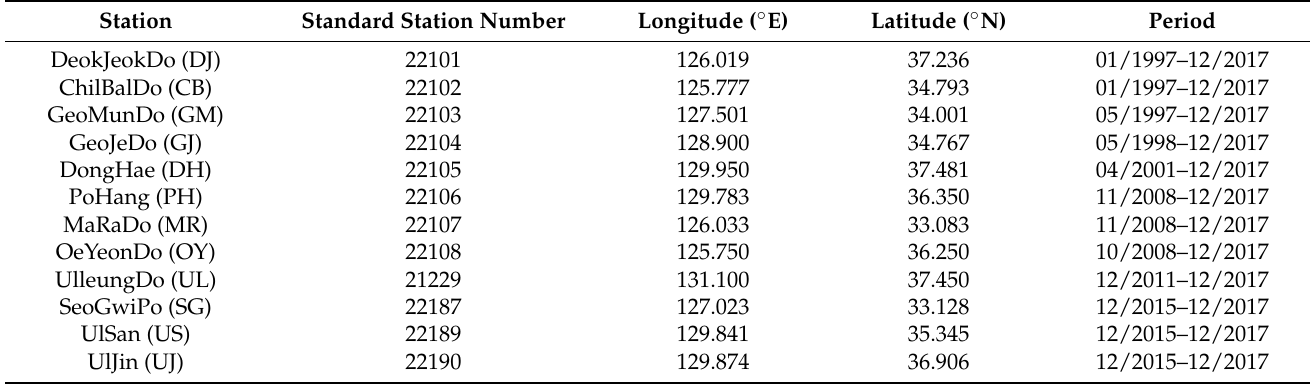
Table 2. Location and observation period of buoy